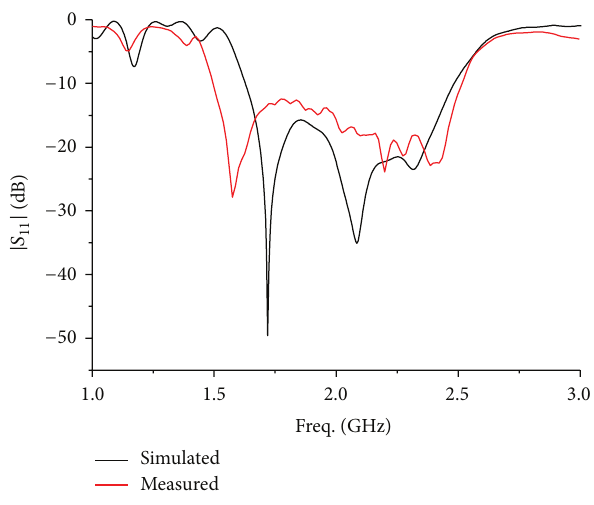
Figure 8: Simulated and measured |𝑆 11 | .